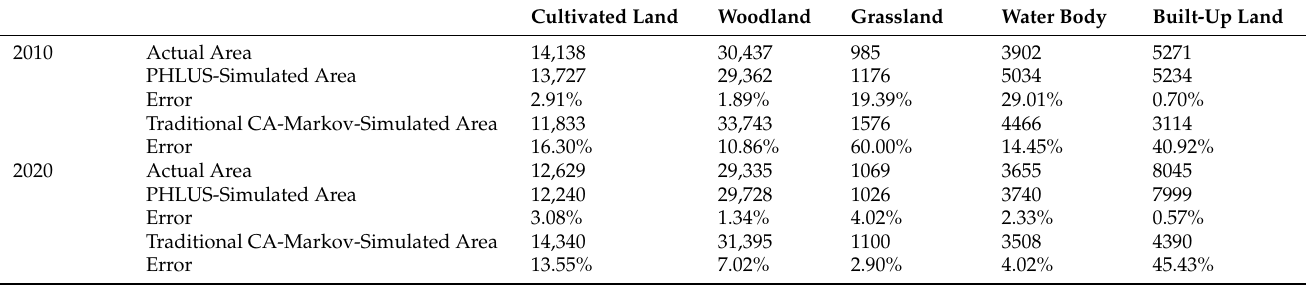
Table 7. Comparison between PHLUS and traditional model.